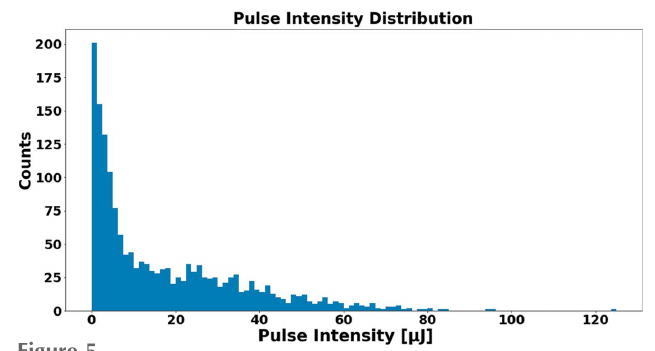
Figure 5 Typical distribution of pulse intensities delivered during the LCLS running, prior to attenuation (if used).